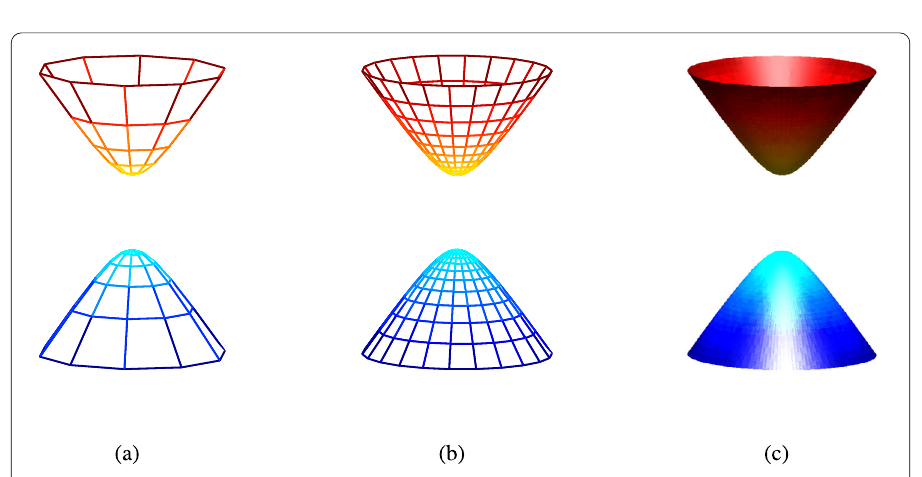
Figure 7 ( a ) indicates the control data sampled from a hyperboloid. The corresponding result s of the first and 7th iterations of subdivision are shown in ( b ) and ( c ),